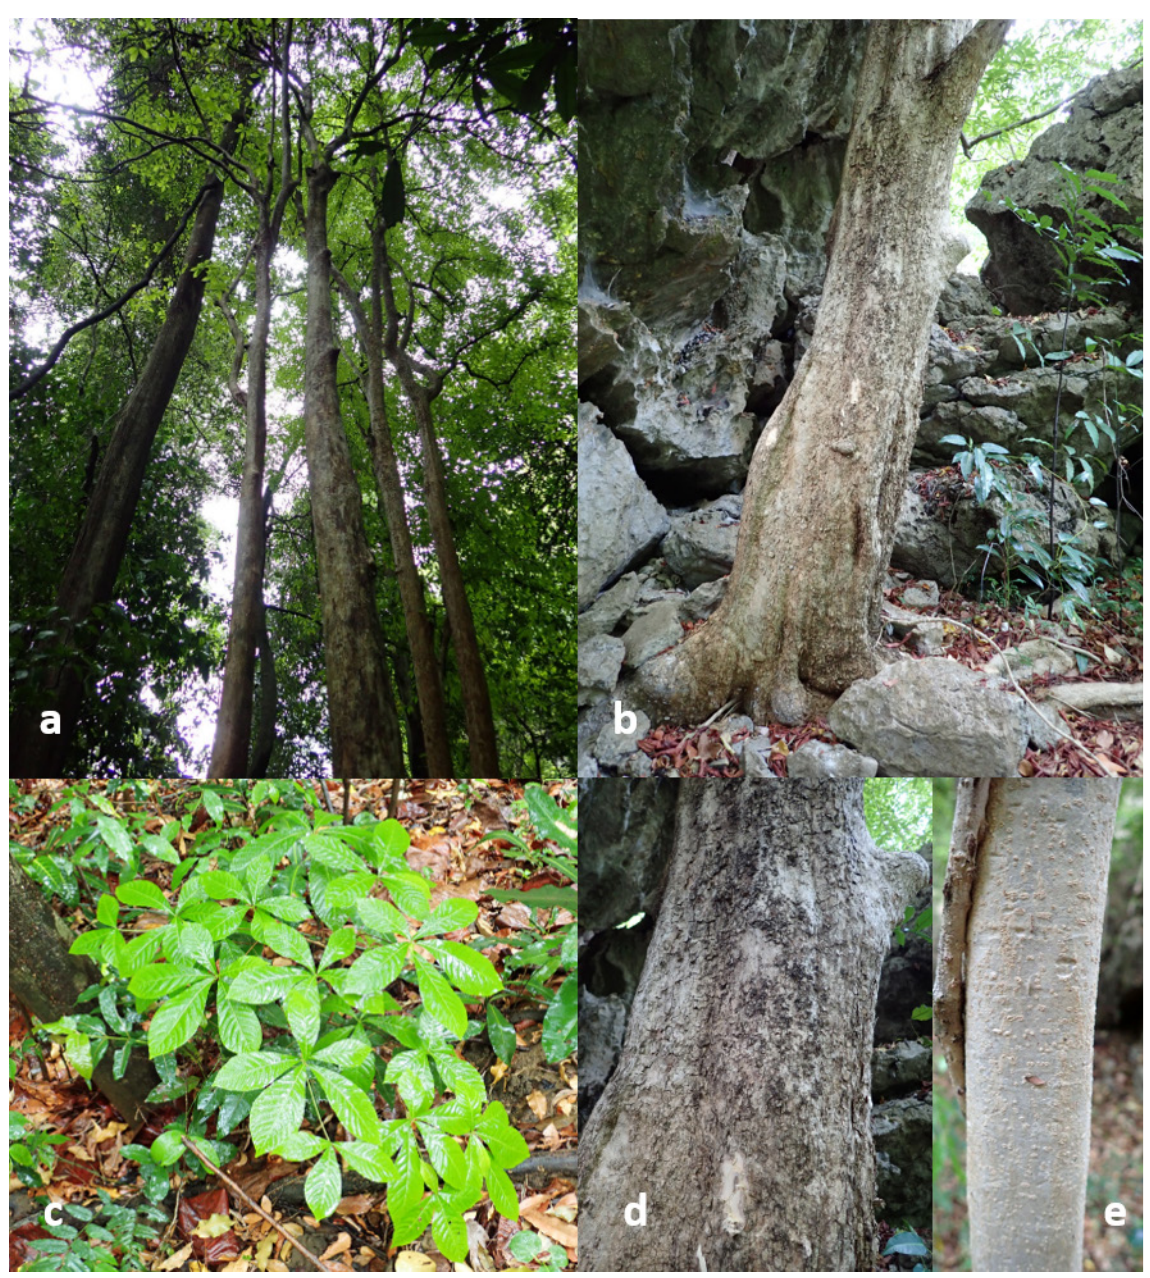
Fig. 4. Field photographs of Paranecepsia andrafiabensis Barberá & O.Lachenaud sp. nov. a . Forest of Paranecepsia andrafiabensis. b . Old trunk. c . Seedlings. d . Detail of old tree trunk. e . Detail of young tree trunk. From Barberá et al. 2769 (b, d), Barberá et al. 2767 (c), Barberá et al. 2798 (e). Photos by P.